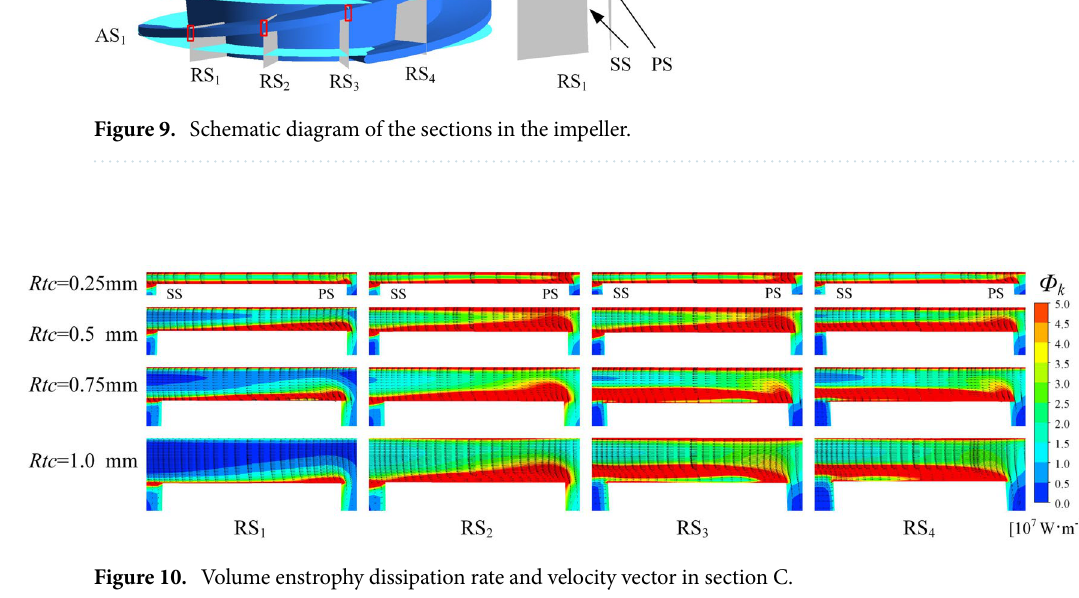
Figure 10. Volume enstrophy dissipation rate and velocity vector in section C.